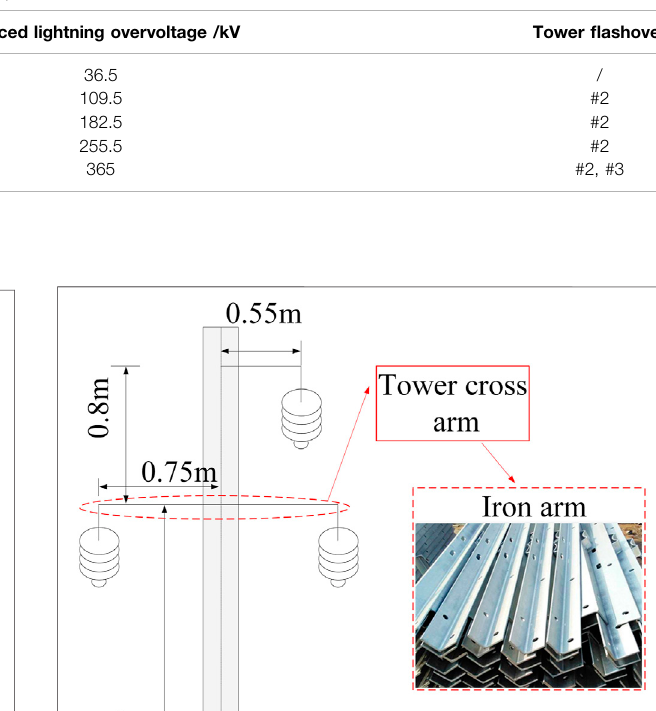
TABLE 3 | Insulator fl ashover at each tower under different lightning current amplitude intrusion.